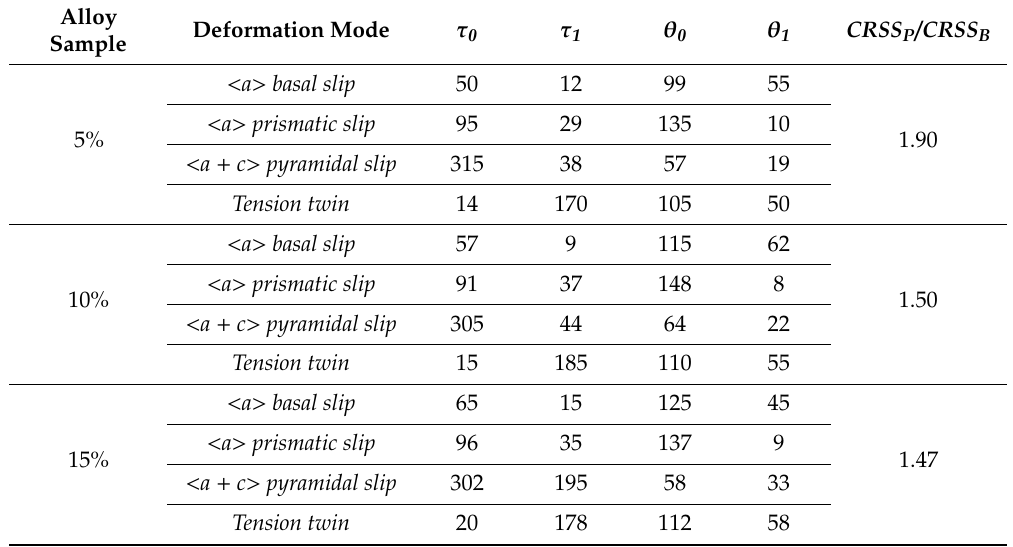
Figure 3. ( a ) Pole figures of the stretched samples obtained by the EBSD measurements and by VPSC modeling. ( b ) CRSSs ratio (prismatic / basal) of single crystal Mg and the stretched samples. ( c ) The activity of basal slip, prismatic slip and tension twins of the AZ31-Ca alloy investigated in the present work. Table 1. CRSS values and hardening parameters for VPSC modeling of the samples (5%, 10%, 15% stretched).